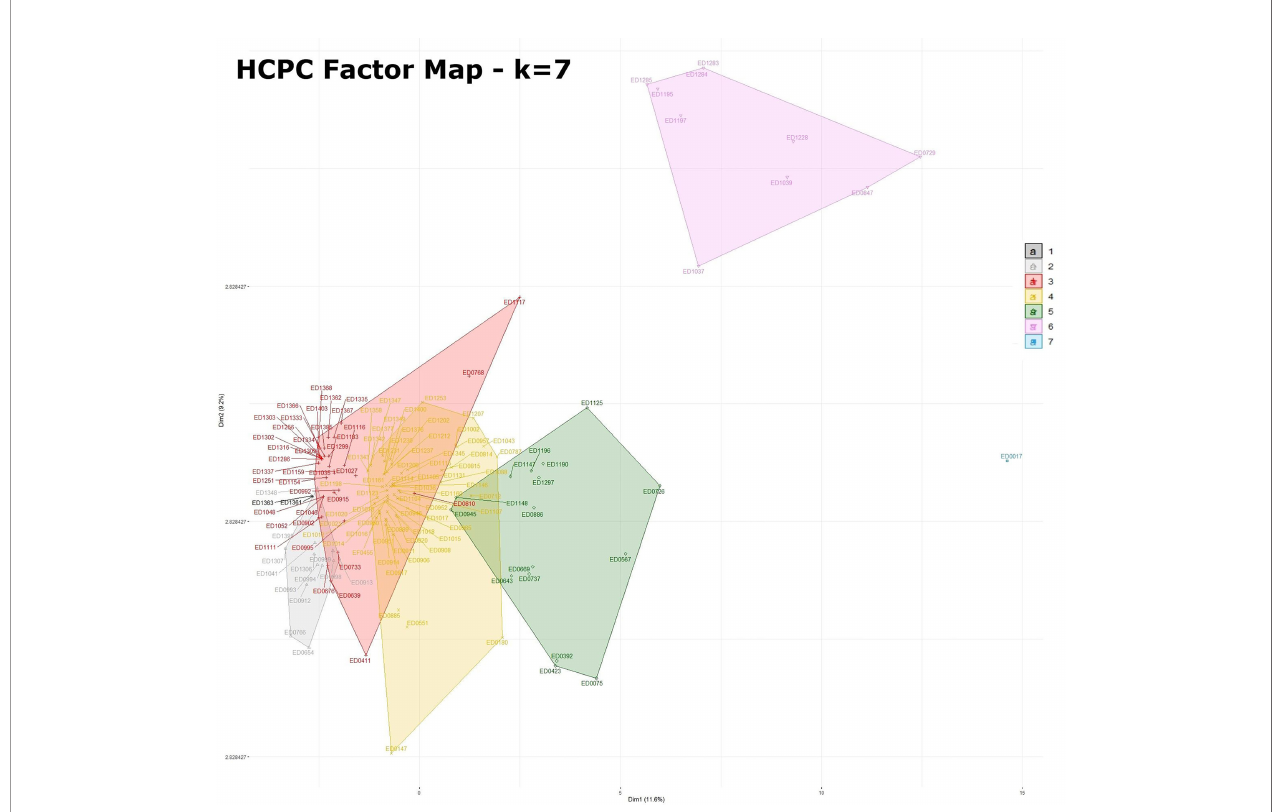
FIGURE 1 | Factor map obtained by HCPC analysis with 7 dimensions. The legend for the colors indicating the clusters is included in the fi gure. Statistics for HCPC analysis are reported in Supplementary Table 2